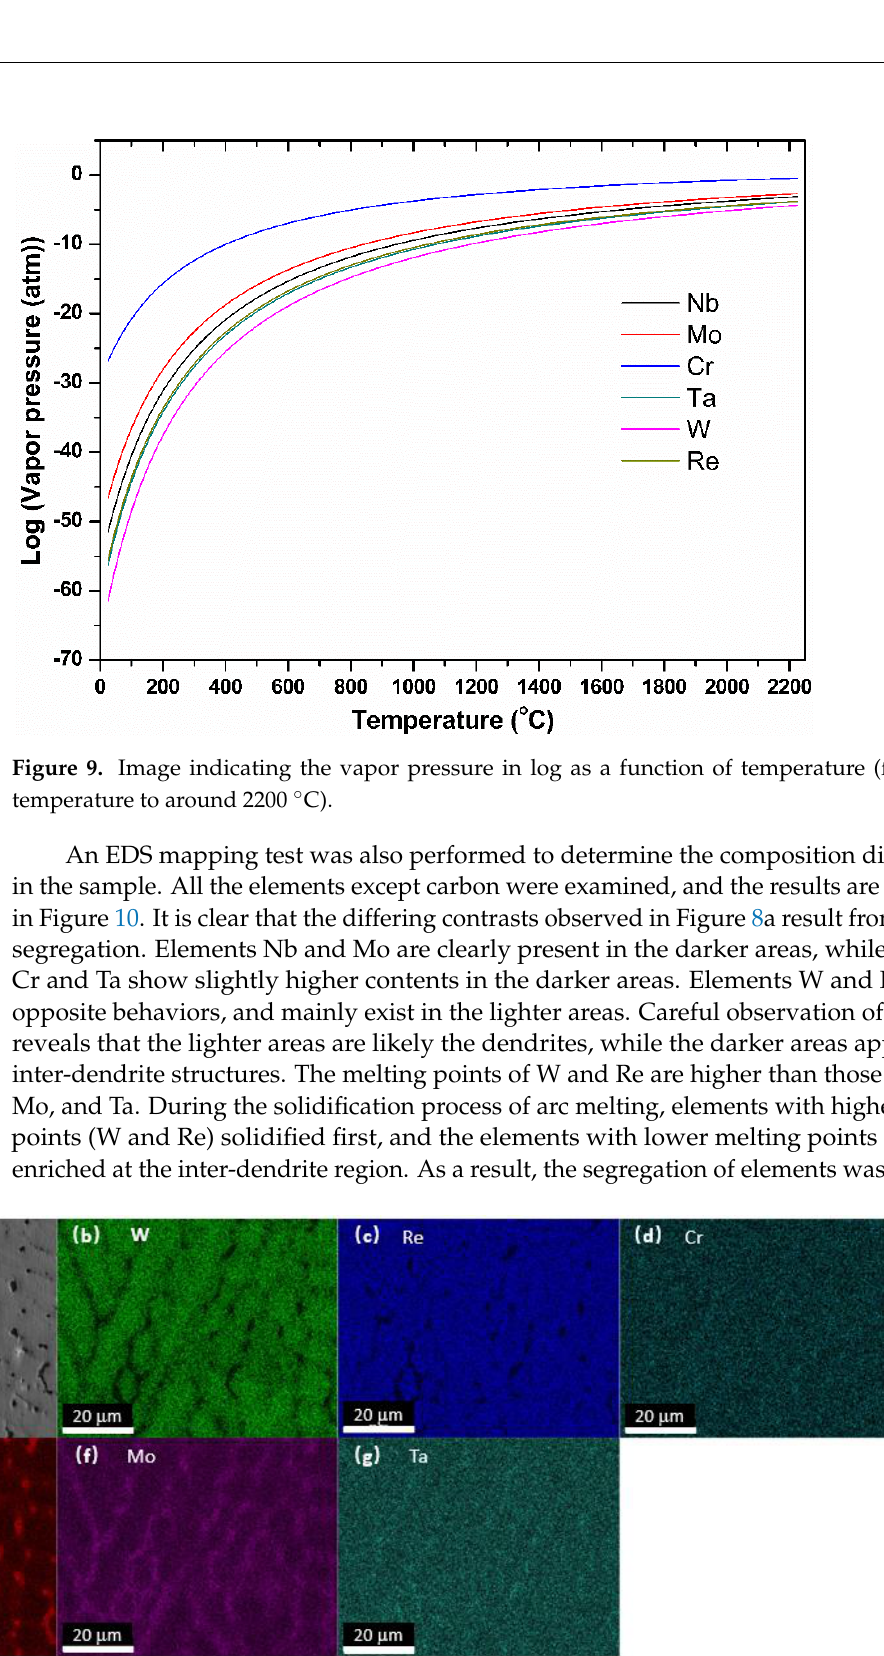
Figure 10. EDS mapping results of the sample C 0.1 Cr 3 Mo 11.9 Nb 20 Re 15 Ta 30 W 20 . ( a ) is the SEM image showing the area for EDS mapping analysis, ( b – g ) indicate the distribution of W, Re, Cr, Nb, Mo and Ta elements, respectively, on the sample area.